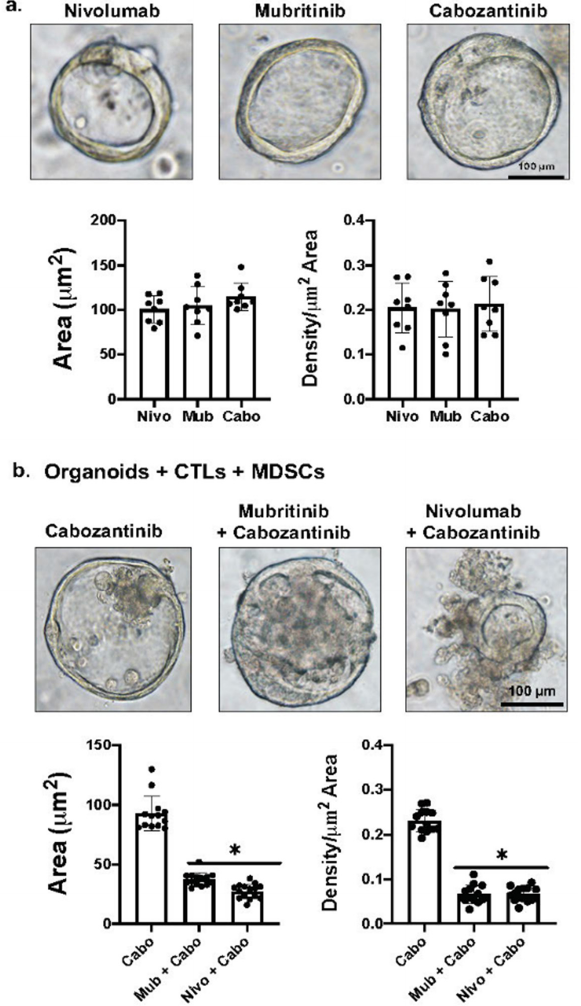
Figure 5. Effect of drug alone on organoid growth and viability. ( a ) Brightfield images and quantification of organoid area using cultures treated with Nivolumab, Mubritinib and Cabozantinib alone. ( b ) Brightfield images and quantification of organoid area using organoid/CTL/MDSC co-cultures treated with Cabozantinib alone, Nivolumab plus Cabozantinib, or Mubritinib plus Cabozantinib. * p < 0.05 compared to Cabozantinib alone. Scale bar = 100 μ m 3.3. Knockdown of HER2 Disrupts AKT/mTOR Signaling and Correlates with a Loss of PD-L1 Expression To assess the relationship between HER2 and PD-L1, lentiviral constructs containing either human shRNA targeting human HER2 (KD) or a scrambled sequence (as a negative control, EV) were used to knockdown HER2. These were applied to huTGOs that exhib- ited expression of HER2 and PD-L1 (Figure 6a–d,m–p). The immunofluorescence staining of four independent TGOs showed a strong association between HER2 and PD-L1